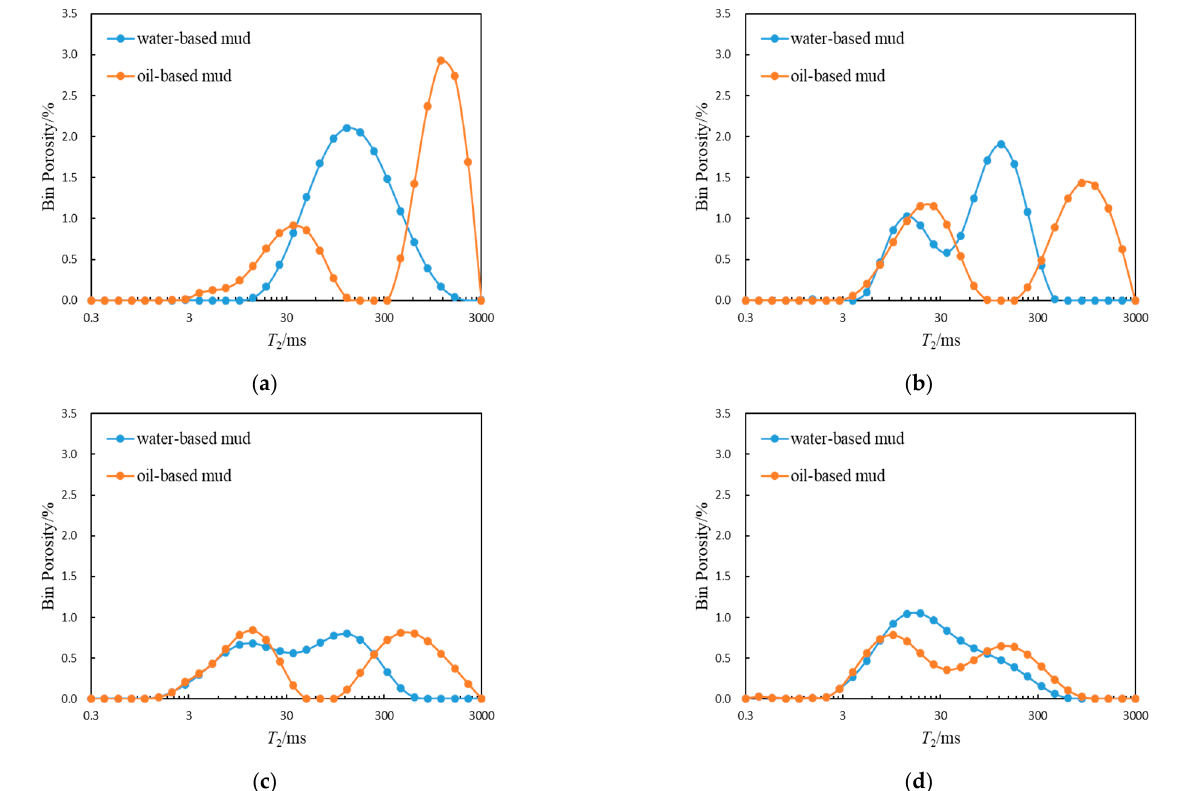
Figure 6. Comparisons of T 2 spectrum of four types of rocks in different mud environments: ( a ) Type I; ( b ) Type II ; ( c ) Type III; ( d ) Type IV. Table 1. T 2 spectrum characteristic parameters of four types of rocks in different mud environments. Rock Structure Type